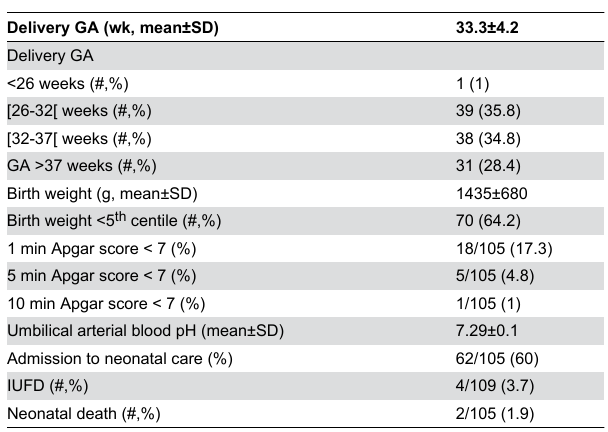
Table 2. Perinatal outcomes. Table 3. Gestational age at the last US